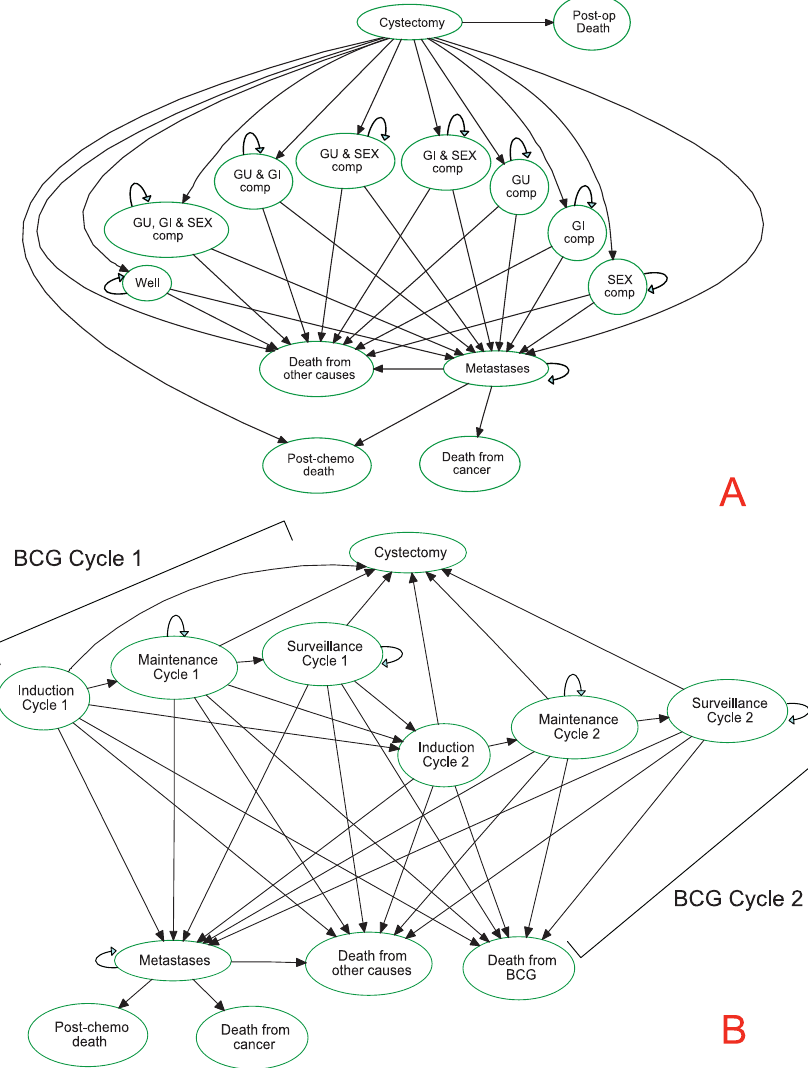
Figure 1. State Transition Diagrams for Immediate Cystectomy (A) and Conservative Therapy with BCG (B) Abbreviations: GI comp, gastrointestinal complications (diarrhea, abdominal pain, or metabolic complications secondary to ileal resection); GU comp, genitourinary complications (incontinence, sepsis, ureteral stenosis, or recurrent urinary tract infections); Mets, metastases; SEX comp, sexual complications (impotence).